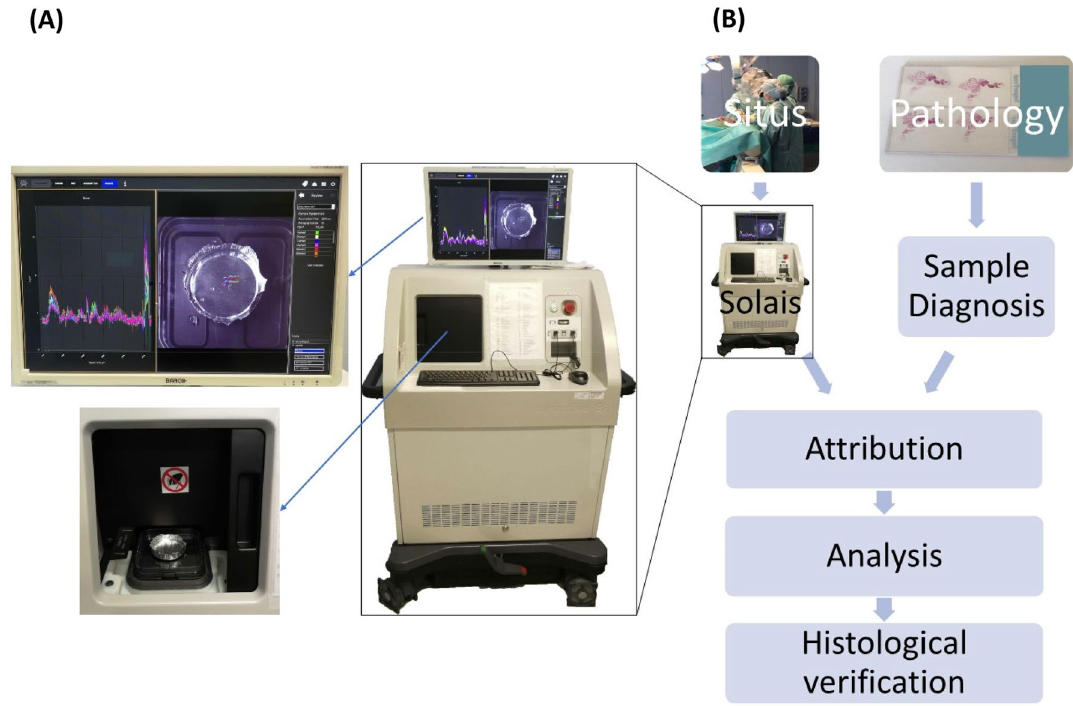
Figure 1. (A) Spectroscopic data acquisition and visualization system with robotized measuring spot navigation (Solais, Synaptive, Toronto, Canada). Upper left: Computer screen with the spectral curves on the left side and the white-light image on the right side. Lower left: Shows the robotized measurement chamber. (B) Flow chart of data